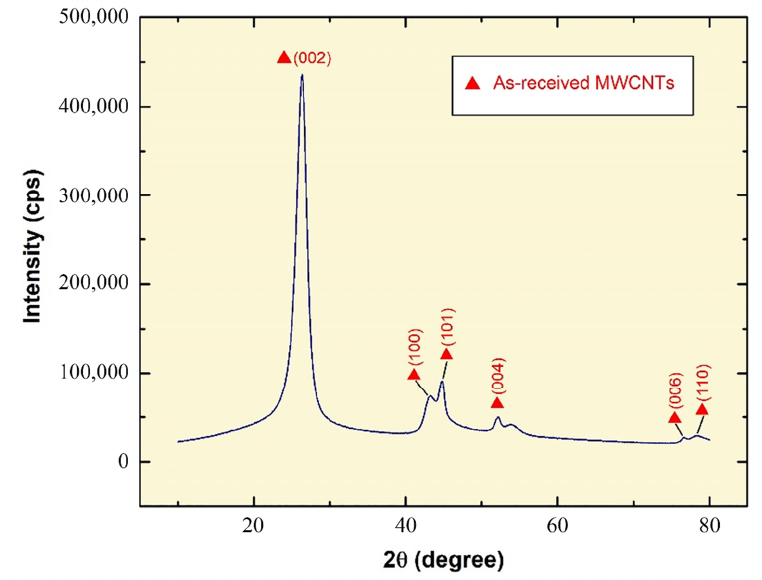
Figure 3. X-ray diffraction patterns of as-received MWCNTs